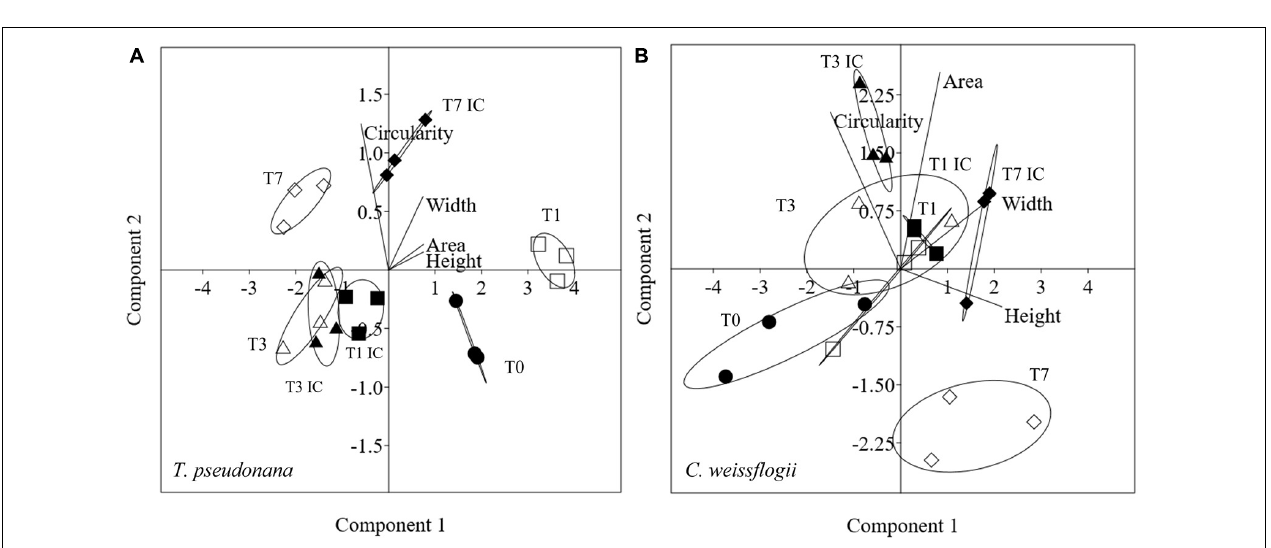
FIGURE 4 | PCA analysis on morphological characteristics in T. pseudonana (A) and C. weissflogii (B) when mixed together. Different symbols indicate different time during the experiment: T0 ◦• ; T1 (cid:3)(cid:4) , T3 (cid:52) (cid:78) , T7 ♦(cid:7) ; white symbols indicate copepods exposure while black symbols indicate absence of copepods and interspecies competition (IC)